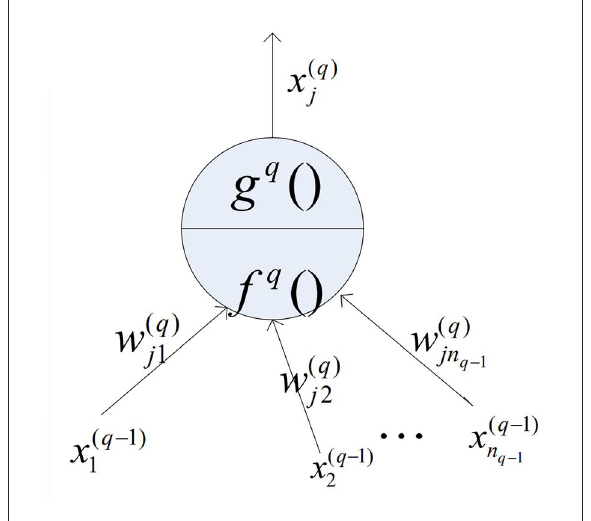
FIGURE1 Neuronal node